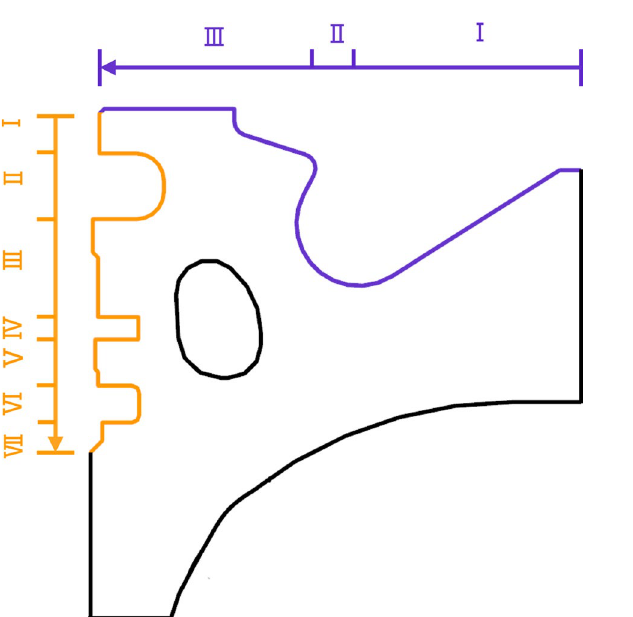
Figure 12. Thermal stress comparison of original design and cluster designs.